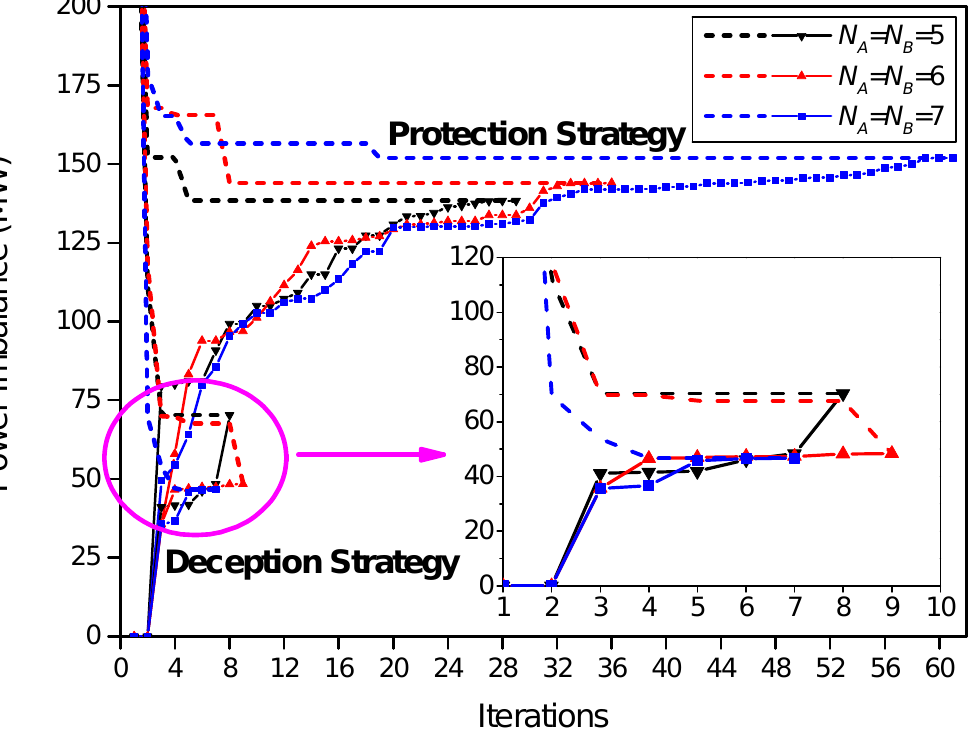
Figure 10. Convergence property of deception and protection